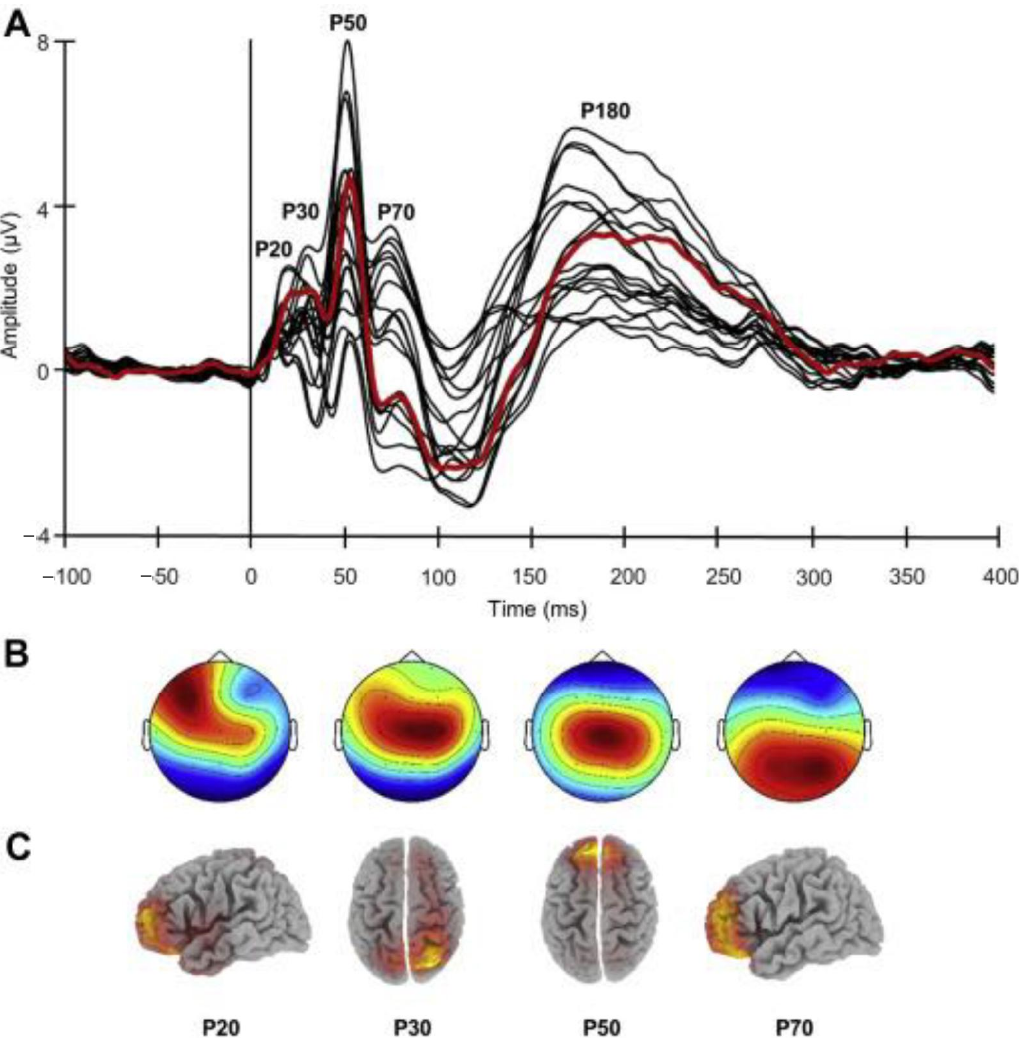
Figure 4. TMS–EEG results. ( A ) Butterfly plot of the grand-averaged TMS-evoked potentials (TEP) from all the electrodes showing the main components elicited by left dorsolateral prefrontal cortex stimulation. The signal from the target site of stimulation (electrode F3) is depicted by the red line. ( B ) Topographic distribution. ( C ) sLORETA source localization for each TEP component before 100 ms. (For interpretation of the references to color in this figure legend, the reader is referred to the Web version of this article). Reproduced with permission from Bagattini et al., 2019 [34].